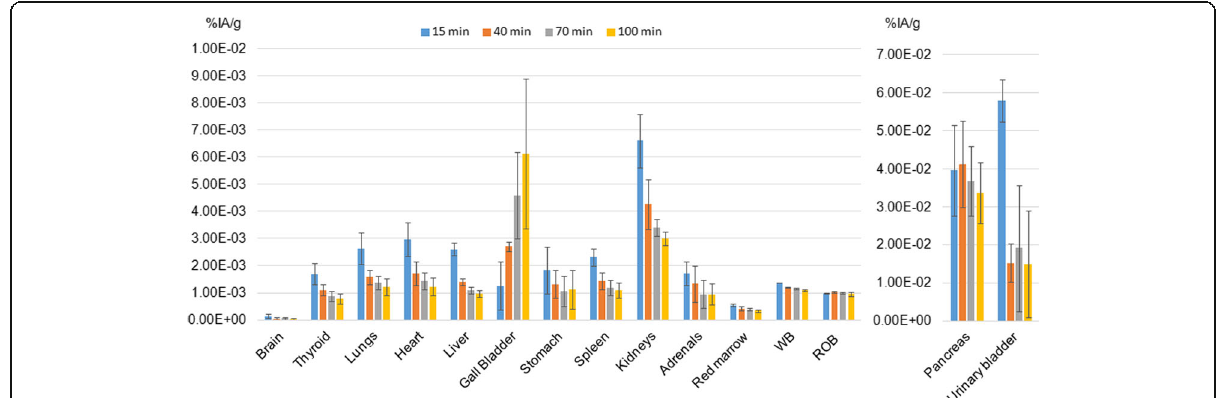
Fig. 3 Biological organ kinetic of 68 Ga-NODAGA-MJ9 corrected for 68 Ga physical decay. Colour bars represent the average percent of injected activity per gram of tissue (%IA/g)± 1SD, for each time